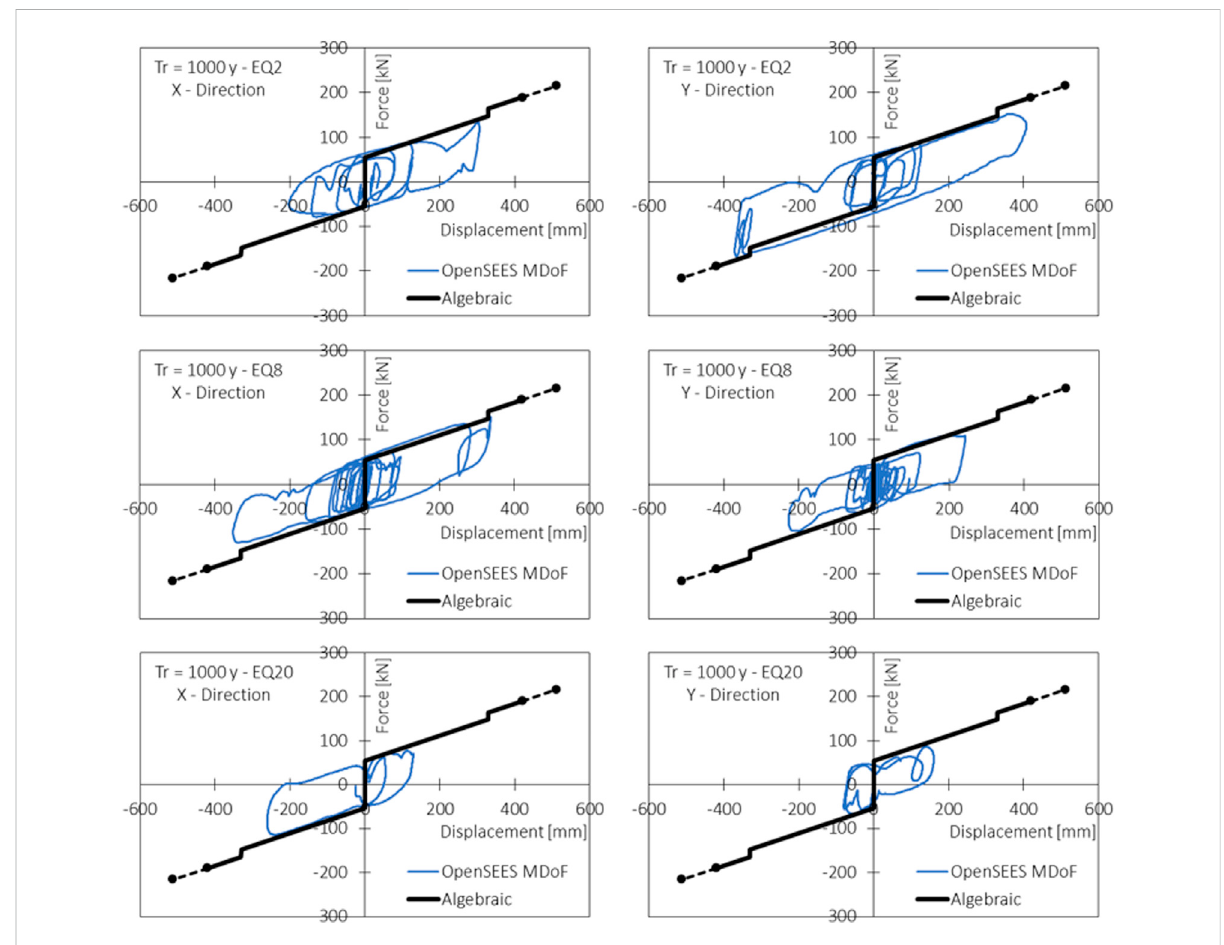
FIGURE 12 Single DCCSS bearing force vs. displacement relationship in X and Y directions for three example earthquakes (EQ2; EQ8; EQ20 for a return period of 1,000